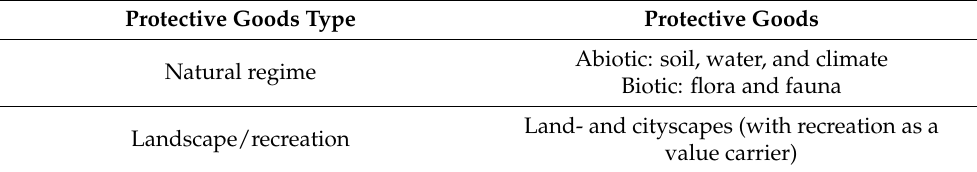
Table 1. Protective goods and superordinate types, adopted from [41] (p. 54). Protective Goods Type Natural regime